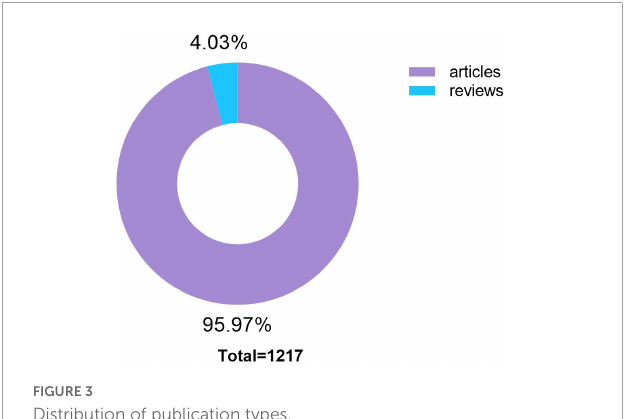
FIGURE3 Distribution of publication types.